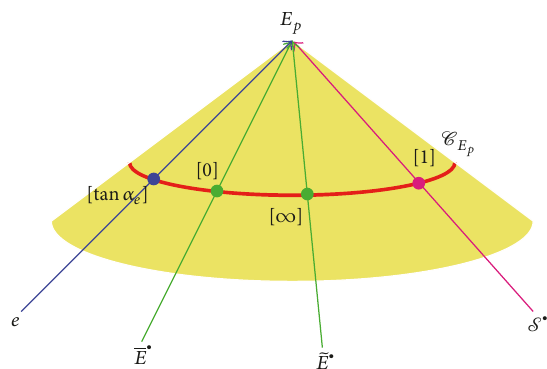
Figure 8: The past null cone and the celestial circle C 퐸